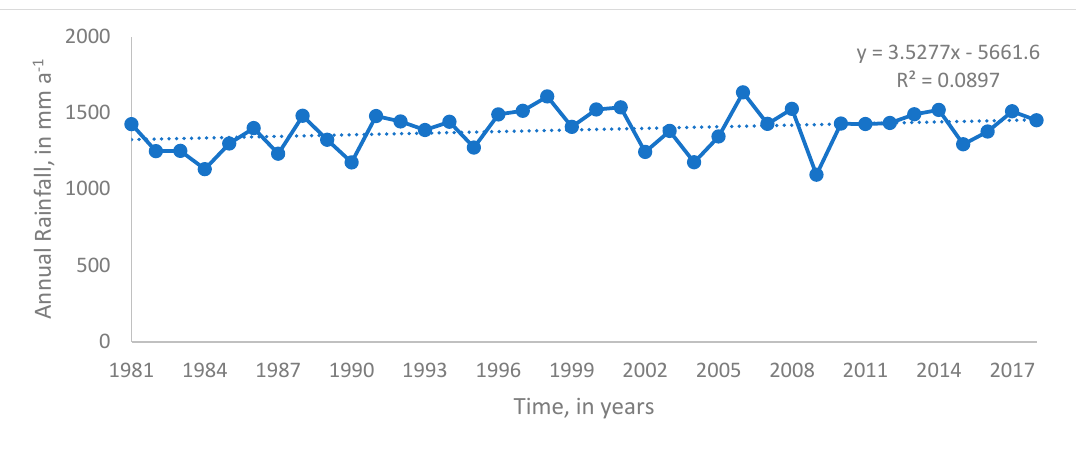
Figure 5. Annual precipitation of Gumara catchment (1981–2018) predicted with “Climate Hazards Group InfraRed Precipitation with Station Data” (CHIRPS). The trend line was found to be increasing at a rate of 4 mm per year.